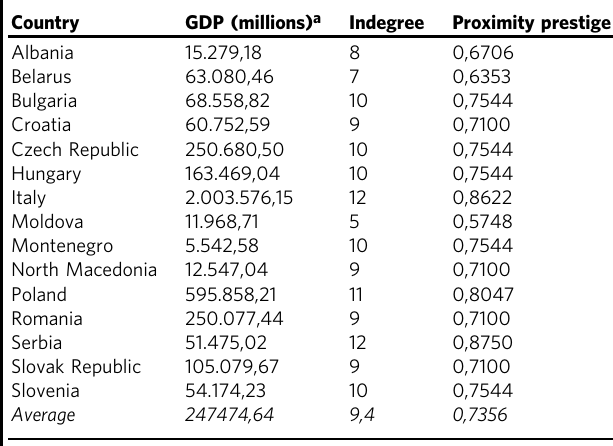
Table 1 Indegree, proximity prestige and GDP of CEI MS: current cooperation.